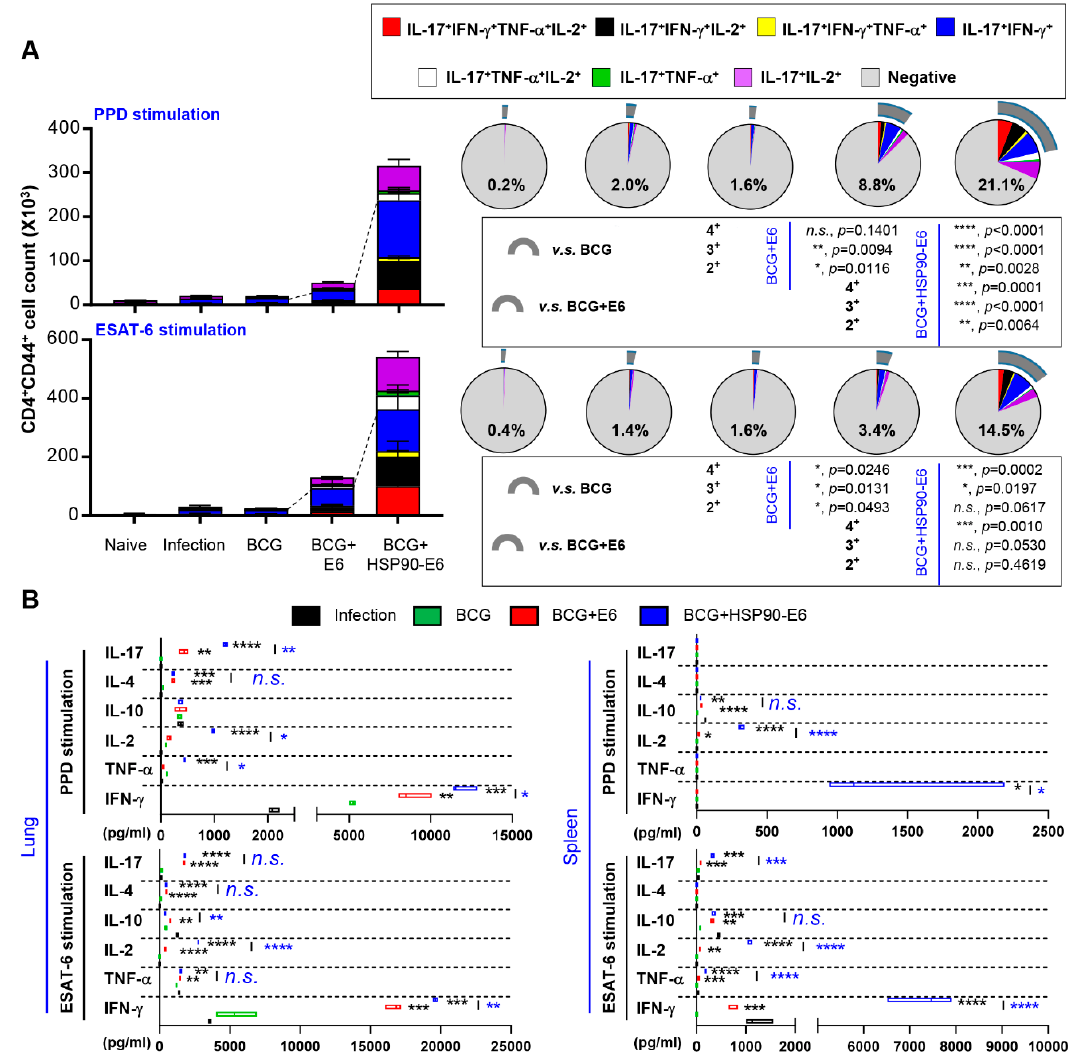
Figure 4. Ag-specific multifunctional T-cell subsets and cytokine production after challenge with Mtb HN878. ( A ) Mice of each group were sacrificed 10 weeks post-infection, and spleen and lung cells obtained from the mice were treated with ESAT-6 (2 μ g/mL) at 37 °C for 12 h in the presence of